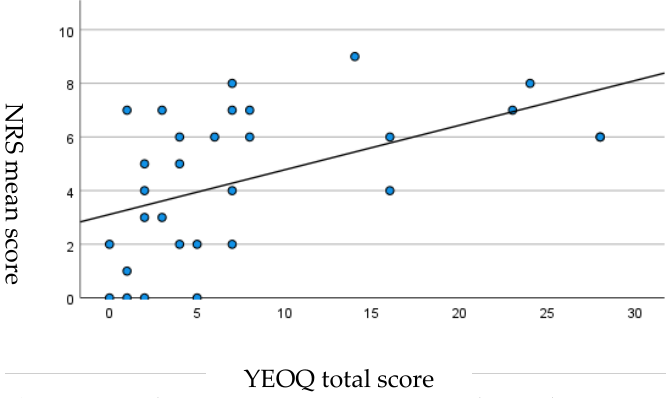
Figure 2. Correlation between NRS mean score during the time interval between the last 2 menstrual periods and YEOQ total score. Pearson ’ s correlation coefficient (r) = 0.51; p = 0.01.